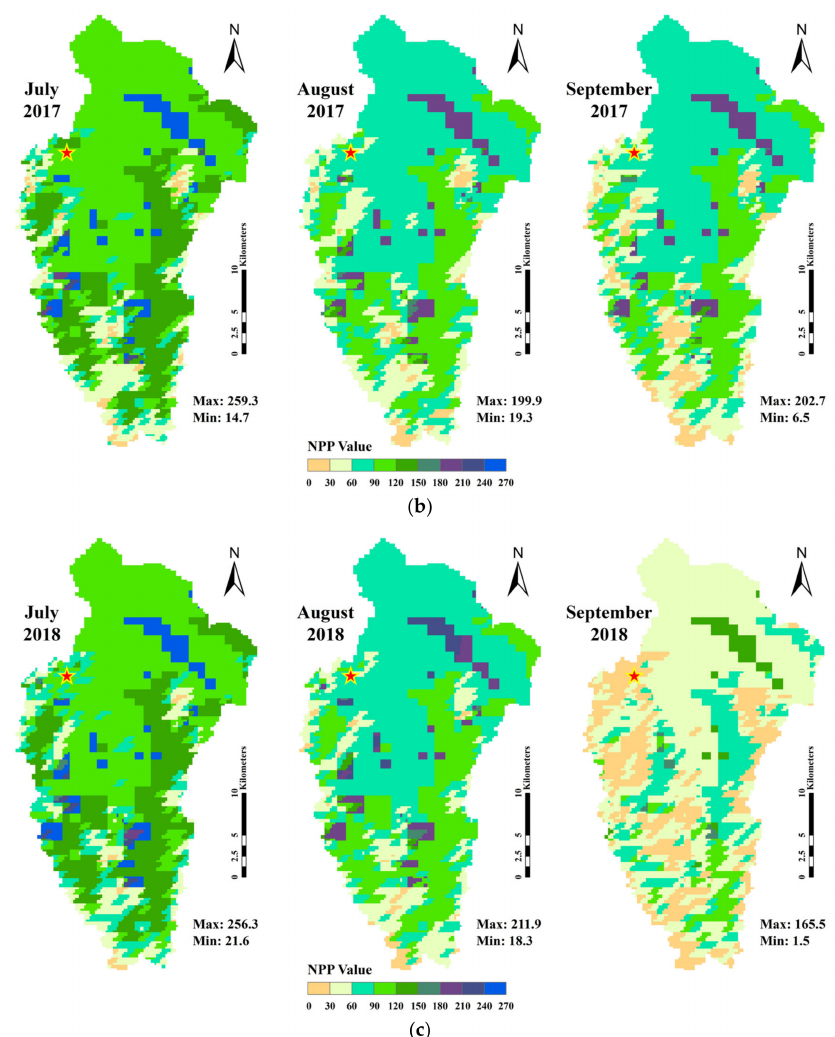
Figure 5. The overview of NPP value within the study region in 2016 ( a ), 2017 ( b ) and 2018 ( c ) (the unit of NPP value was unified as gC/m 2 ).